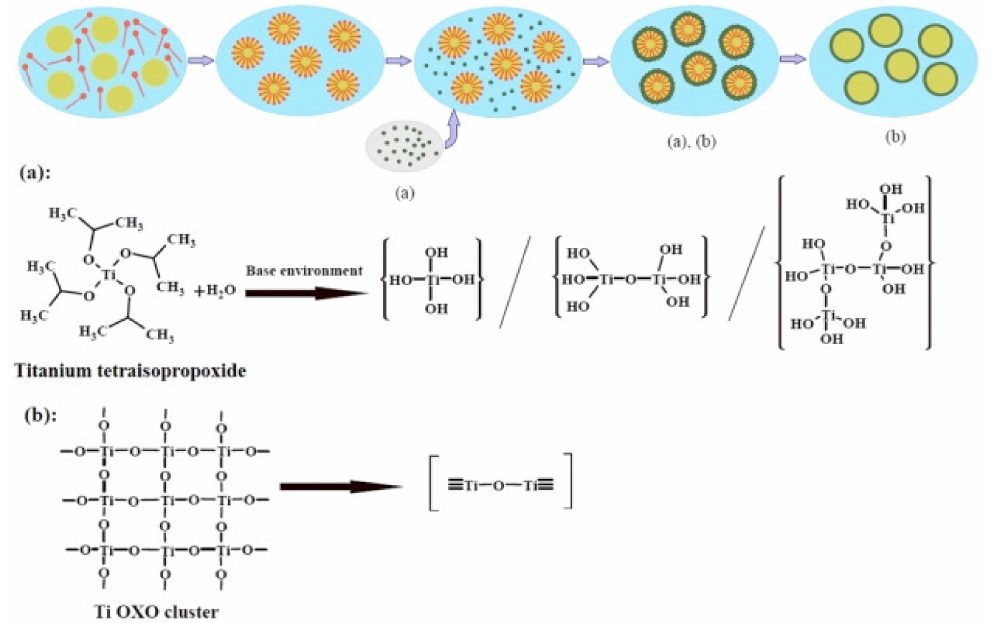
Figure 13. The hydrolysis and condensation steps of titania precursor